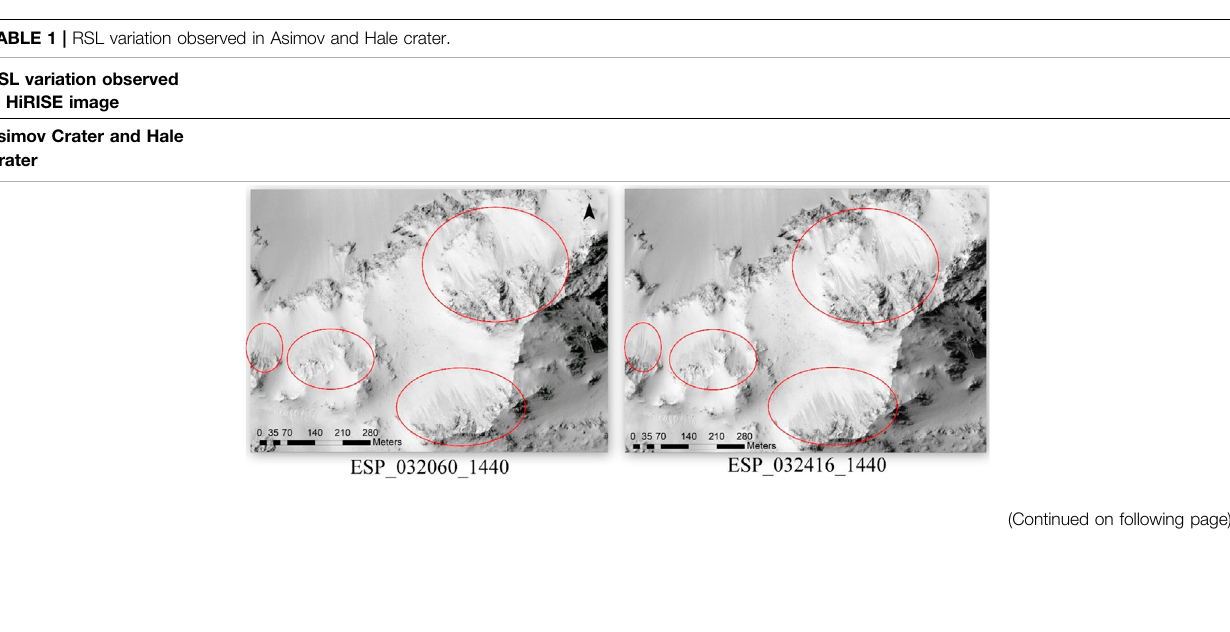
TABLE 1 | RSL variation observed in Asimov and Hale